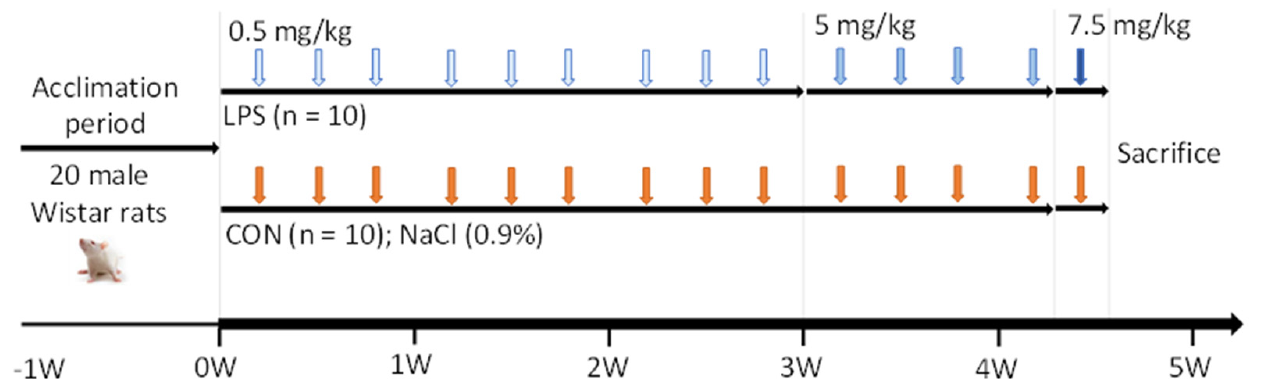
Figure 7. Schematic representation of the LPS-induced chronic inflammation model. The experi- mental model consisted of two groups that received intraperitoneal (IP) injections of increasing LPS and saline solution (NaCl 0.9%) for 31 days. Abbreviations: W, week; CON, control group; LPS, LPS-induced inflammation group.